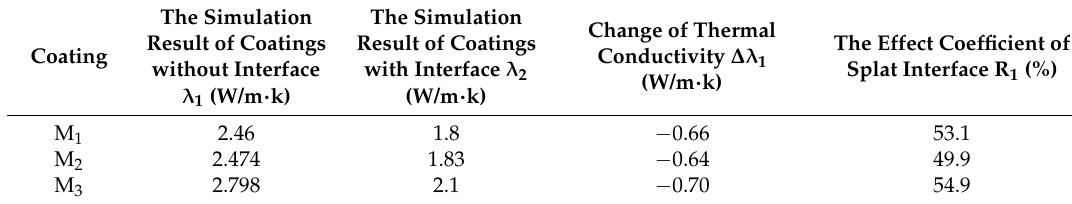
Figure 7. Thermal flux of coatings with splat interface ( a ) M 1 , ( b ) M 2 and ( c ) M 3 . Table 6. The simulation results λ 1 , λ 2 , the effect coefficient R 1 .